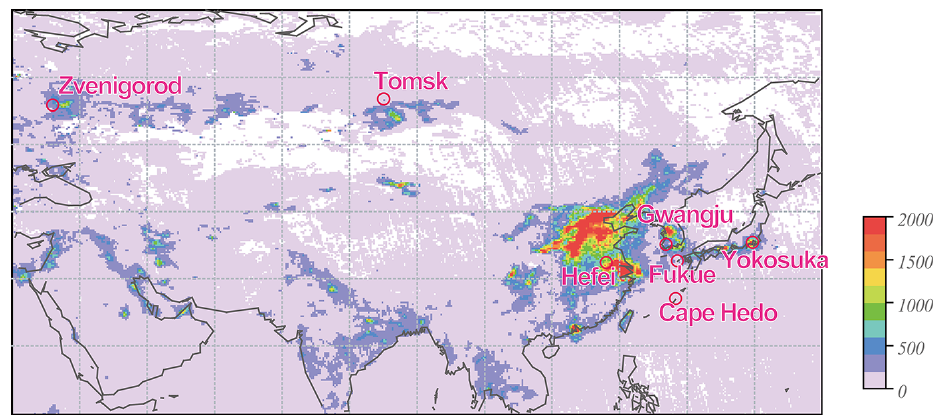
Figure 3. Locations of our MAX-DOAS observations. The background contour is based on the TropoNO 2 VCD (10 13 moleculescm − 2 ) observed by OMI (DOMINO ver. 2.0).